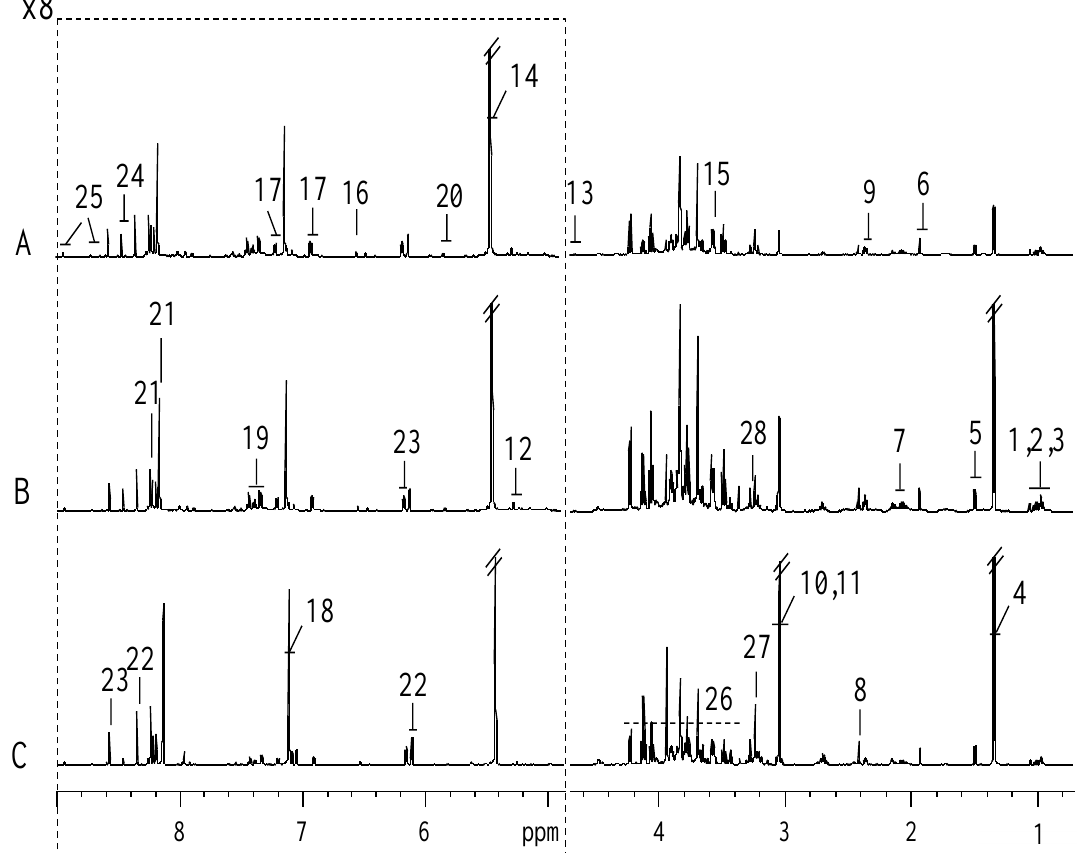
Figure 1. Representative 600 MHz 1 H NMR spectra of stewed pork-hock in soy sauce (SPHSS) ( A ), stewed pork-hock (SPH) ( B ) and marinated and roasted pork-hock (MRPH) ( C ). The dotted region was vertically expanded eight times. Resonance assignments are given in Table 1. Keys: 1. isoleucine; 2. leucine; 3. valine; 4. lactate; 5. alanine; 6. acetate; 7. glutamate; 8. succinate; 9. pyroglutamate; 10. creatine; 11. creatinine; 12. α -glucose; 13. β -glucose; 14. sucrose; 15. glycine; 16. fumarate; 17. tyrosine; 18. histidine; 19. phenylalanine; 20. uracil; 21. hypoxanthine; 22. inosine; 23. 5 (cid:48) -IMP; 24. formate; 25. nicotinamide; 26. sugars and amino acids; 27. phosphorylcholine; 28.